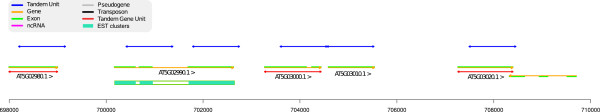
An example of duplicated gene fusion. Region 698,000-710,000 of chromosome 5. In this TA, four TUs match coding genes. The two remaining TUs appear each in a single fusion gene that has apparently been built by merging successive duplication units. The A. thaliana EST clusters (extracted from Gramene web site, Ensembl Plants Arabidopsis thaliana version 62.10), mapped to the region on the Gramene web site, effectively confirm the existence of an intron in this gene connecting the two duplicated regions.